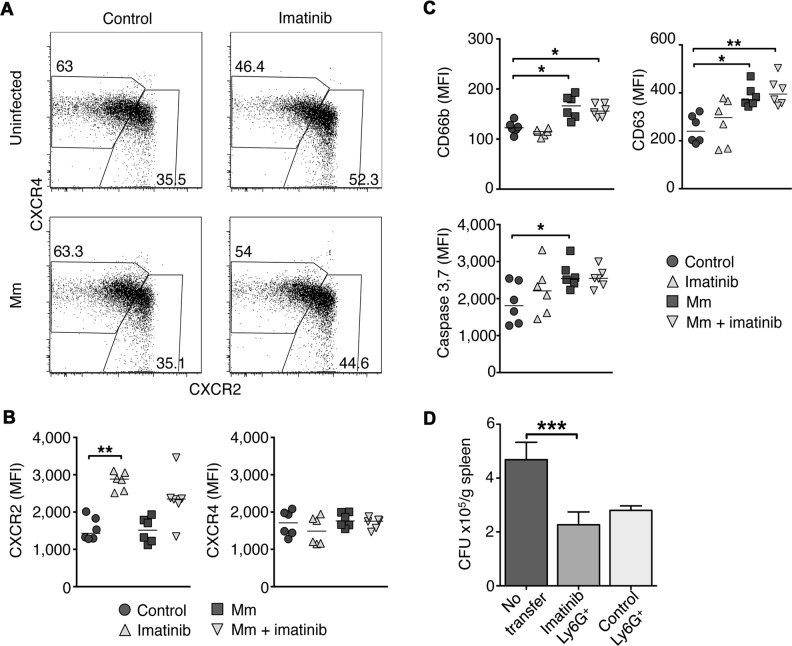
Effects of Imatinib on CXCR2 expression, activation, and apoptosis in neutrophils.C57Bl/6 mice were administered imatinib at 66 mg/kg/d or left untreated. Beginning 24h post-treatment mice were either injected in the tail vein with 105 CFU Mm 1218R or left uninfected. At 7d post-treatment, bone marrow was collected from both femurs. (A) Representative flow cytometry plots of CXCR4 and CXCR2 expression on neutrophils from bone marrow using flow cytometry. CXCR2hiCXCR4lo and CXCR4hiCXCR2lo subsets were identified, and frequencies of total neutrophils are displayed in boxes. (B) Median fluorescence intensity (MFI) of CXCR2 and CXCR4 on neutrophils from bone marrow. Cumulative data from two independent experiments are presented with six mice per condition. The line in each data set represents the median. (C) C57Bl/6 mice were treated as in A. Activation status was assessed by surface expression of CD66b (secondary granules), CD63 (primary granules) and apoptosis by intracellular staining for caspase 3 and 7 activity of the total neutrophils (Ly6G+Ly6C+) from spleen. Cumulative data from two independent experiments are presented with 6 mice per condition. (D) C57Bl/6 mice were administered imatinib at 66mg/kg/d or left untreated. On d7, splenic neutrophils were isolated using Ly6G+ microbeads and 4 x106 cells were injected via the left tail vein into each naïve recipient mice, and infected via the right tail vein with 105 CFU Mm. Forty eight hours later, spleens were harvested and CFU/gram were determined. CFU/g spleen from mice injected with carrier, or with neutrophils from imatinib-treated mice or mice treated with carrier (water). Cumulative data from three independent experiments are presented with 15–25 animals per condition. The line represents the median. A Mann-Whitney test was used for pairwise comparisons, and a Kruskal Wallis test for multiple comparisons.